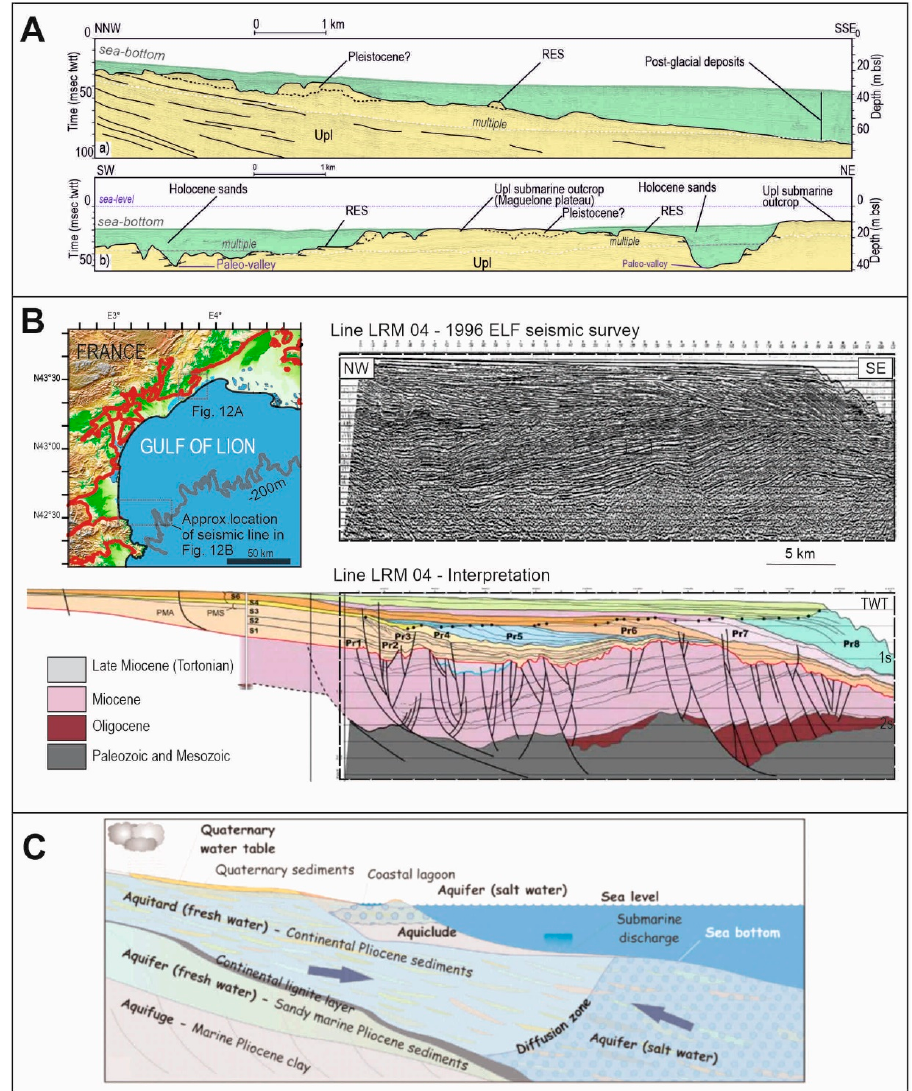
Figure 12. ( A ) Dip and strike high-resolution seismic profiles (IX-Survey-07 and 39) acquired offshore of the Maguelone lido [46]. In the dip profile, the Upl (upper Pliocene) reflections are gently dipping toward the sea at an angle of approximately 0.5°. The strike profile images the details of the Upl unit, which consist of low frequency, sub-parallel continuous reflections. Upl is eroded at the top by the RES and deeply incised in the axis of paleo-valleys inherited from the last glacial maximum. The Holocene permeable sands discordantly overlie the RES. Upl outcrops locally at the sea floor. Beneath the lido, salt water saturates the upper ~30 m and is thought to result from a connection of the aquifers with the sea either directly in places where Upl outcrops offshore or indirectly via the paleo-channels that may have breached a confining unit. ( B ) Pliocene–Quaternary correlations between onshore and offshore (seismic profile LRM04) formations in the Roussillon Basin area (modified from Reference [131]). Plio- Quaternary stratigraphy and systems tracts: PR1-8 (PR1-3: Zanclean Gilbert deltas foresets and bottomsets, PR4-6: Zanclean topsets, foresets and bottomsets, Pr7: Piacenzian topsets, foresets and bottomsets, Pr8: Gelasian/Quaternary topsets, foresets and bottomsets). ( C ) Hydrogeological conceptual model of the Roussillon aquifer system without scale and location [130]. Sea water intrusion occurs in the unconfined superficial Quaternary aquifer in the offshore domain (more than 5 km from the coastline, based on morphobathymetric map observations). Submarine groundwater discharge could occur in the open sea, although it has not been directly